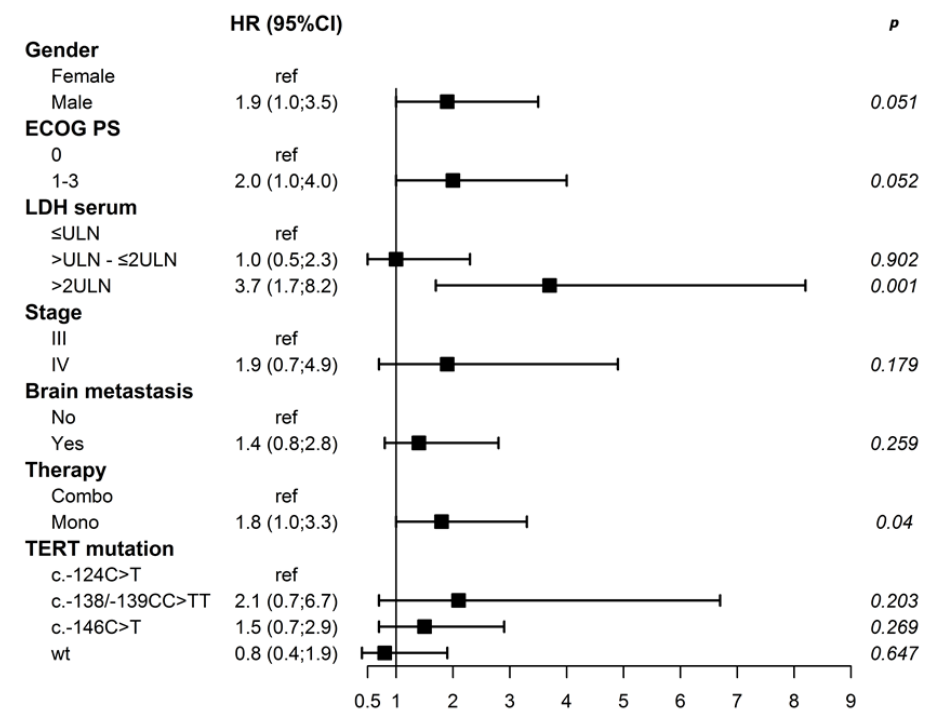
Figure 2. Forest plot showing hazard ratios for overall survival using a multivariable Cox proportional hazards model.